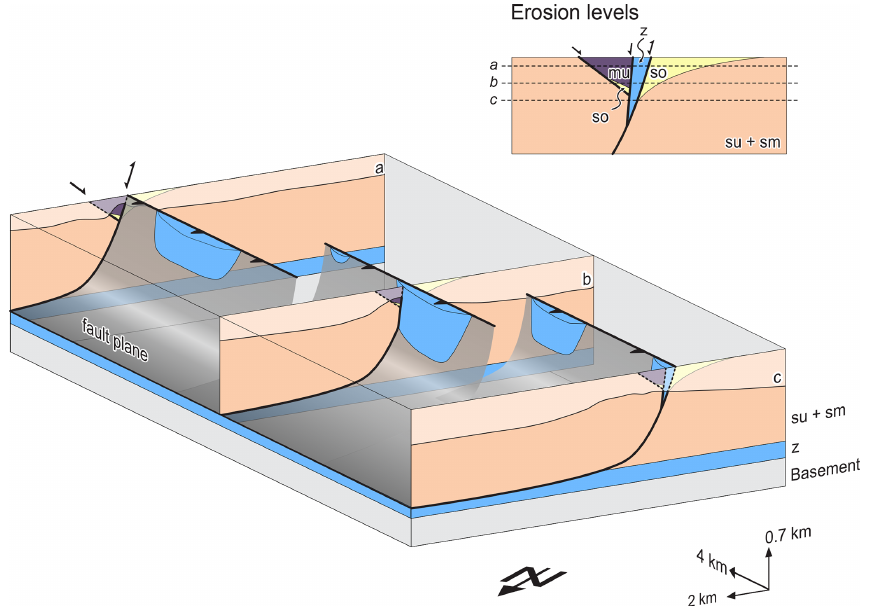
Figure 12. Schematic model explaining the appearance of multiple rows of Zechstein slivers along imbricated faults as part of a transfer-type structure observed in the western part of the graben (section I, Fig. 4). Different erosion levels determine the width of the graben as it appears on the